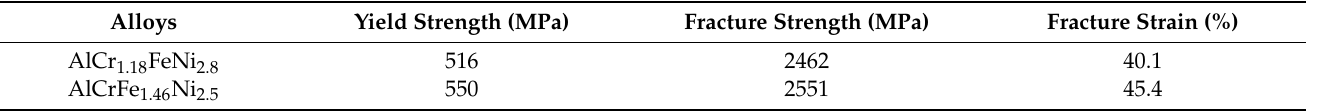
Table 3. Compressive properties of AlCr 1.18 FeNi 2.8 and AlCrFe 1.46 Ni 2.5 alloys.